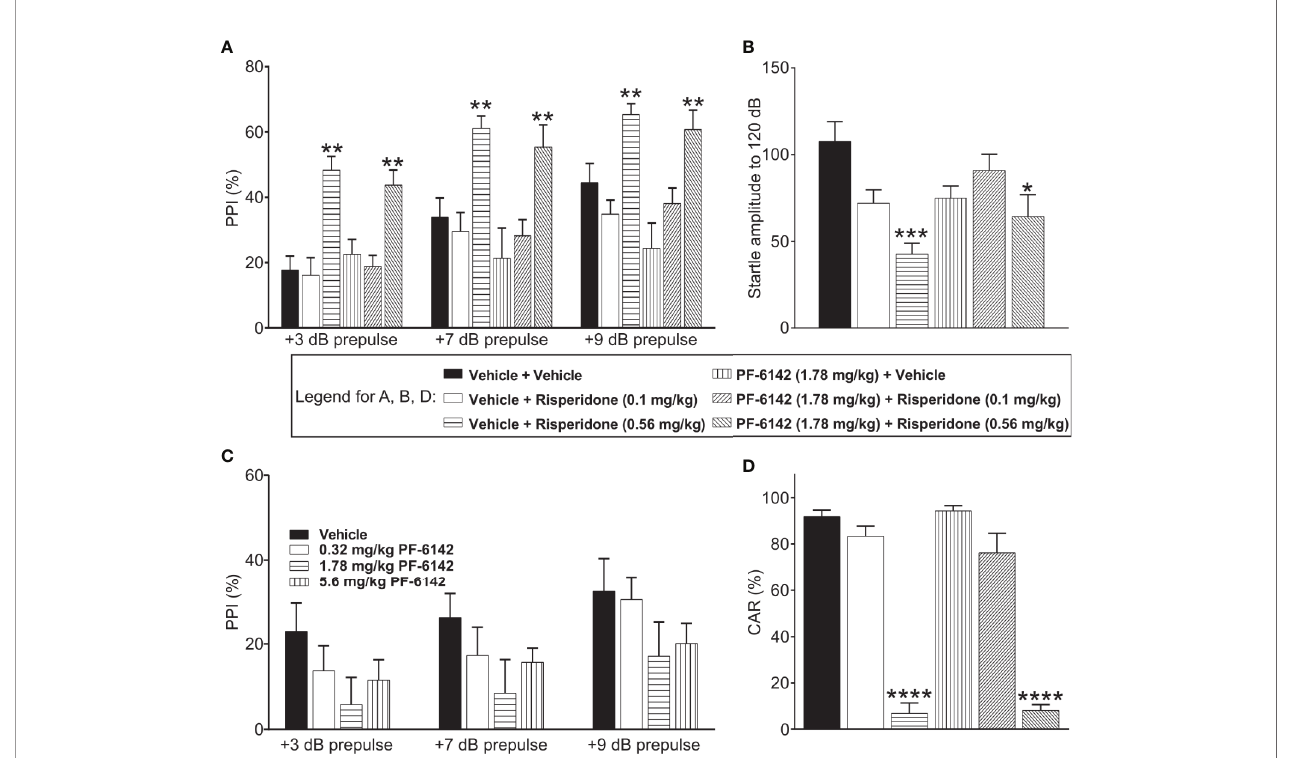
FIGURE 4 | PF-6142 Does not alter the antipsychotic-like activity of risperidone in rodents. (A) As expected, risperidone produced increases % PPI in adult male C57BL/6J mice consistent with an antipsychotic-like pro fi le in this assay. Administration of PF-6142 alone or in combination with risperidone does not alter PPI responses (n=8 per treatment group). (B) Statistically signi fi cant reductions in startle responses were observed with the highest dose of risperidone (0.56 mg/kg) which was not altered in the presence of PF-6142. ( C) PF-6142 alone produced modest non-signi fi cant reductions in % PPI in adult C57BL/6J mice. ( D) Risperidone produces signi fi cant reductions in avoidance responding consistent with antipsychotic-like activity in adult male rats (n=8 – 9 per treatment) in the conditioned avoidance responding assay. There is no effect of PF-6142 alone or in combination with risperidone in avoidance responding. One-way ANOVA with Tukey ’ s post-test adjusted *p < 0.05, **p < 0.01 vs. vehicle + Risperidone (0.56 mg/kg) ***p < 0.001 vs. vehicle + vehicle. Note:2-way RM ANOVA (A). One-way ANOVA with Dunnett ’ s post-hoc test ****p < 0.0001 vs. vehicle + vehicle (D)